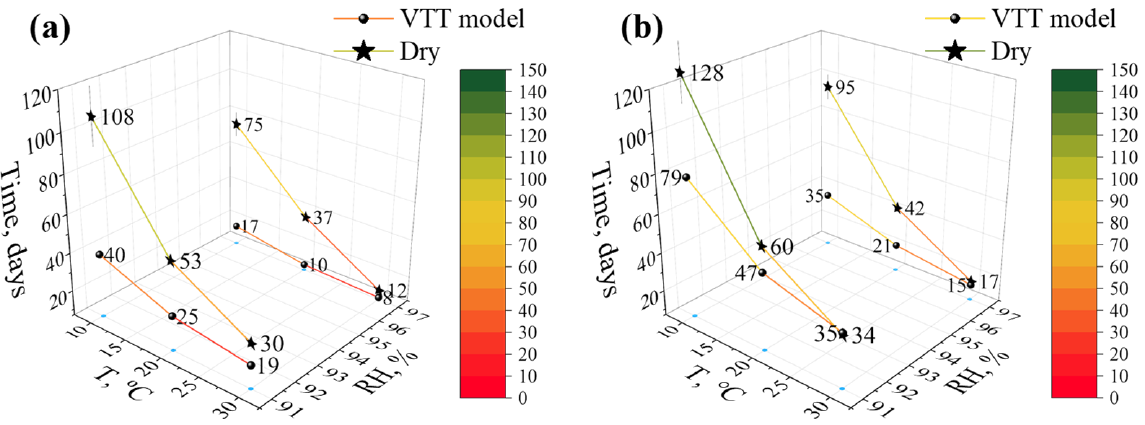
Figure 2. Effect of temperature (10, 20 and 30 °C) and RH (91% and 97%) on the time necessary to reach ( a ) mould germination and ( b ) visible mould growth stages in the experiment I (‘Dry’) and calculated according to the VTT model [24]; light blue dots on the T and RH plane are the corresponding projections of the